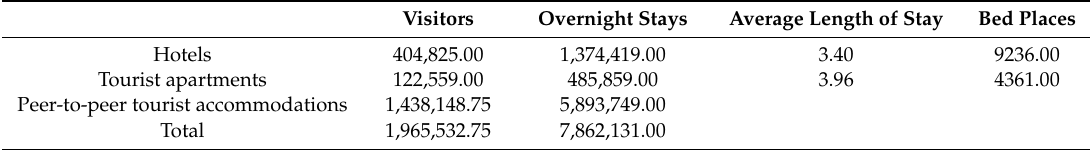
Table 1. Key data of the tourism industry in Ibiza,